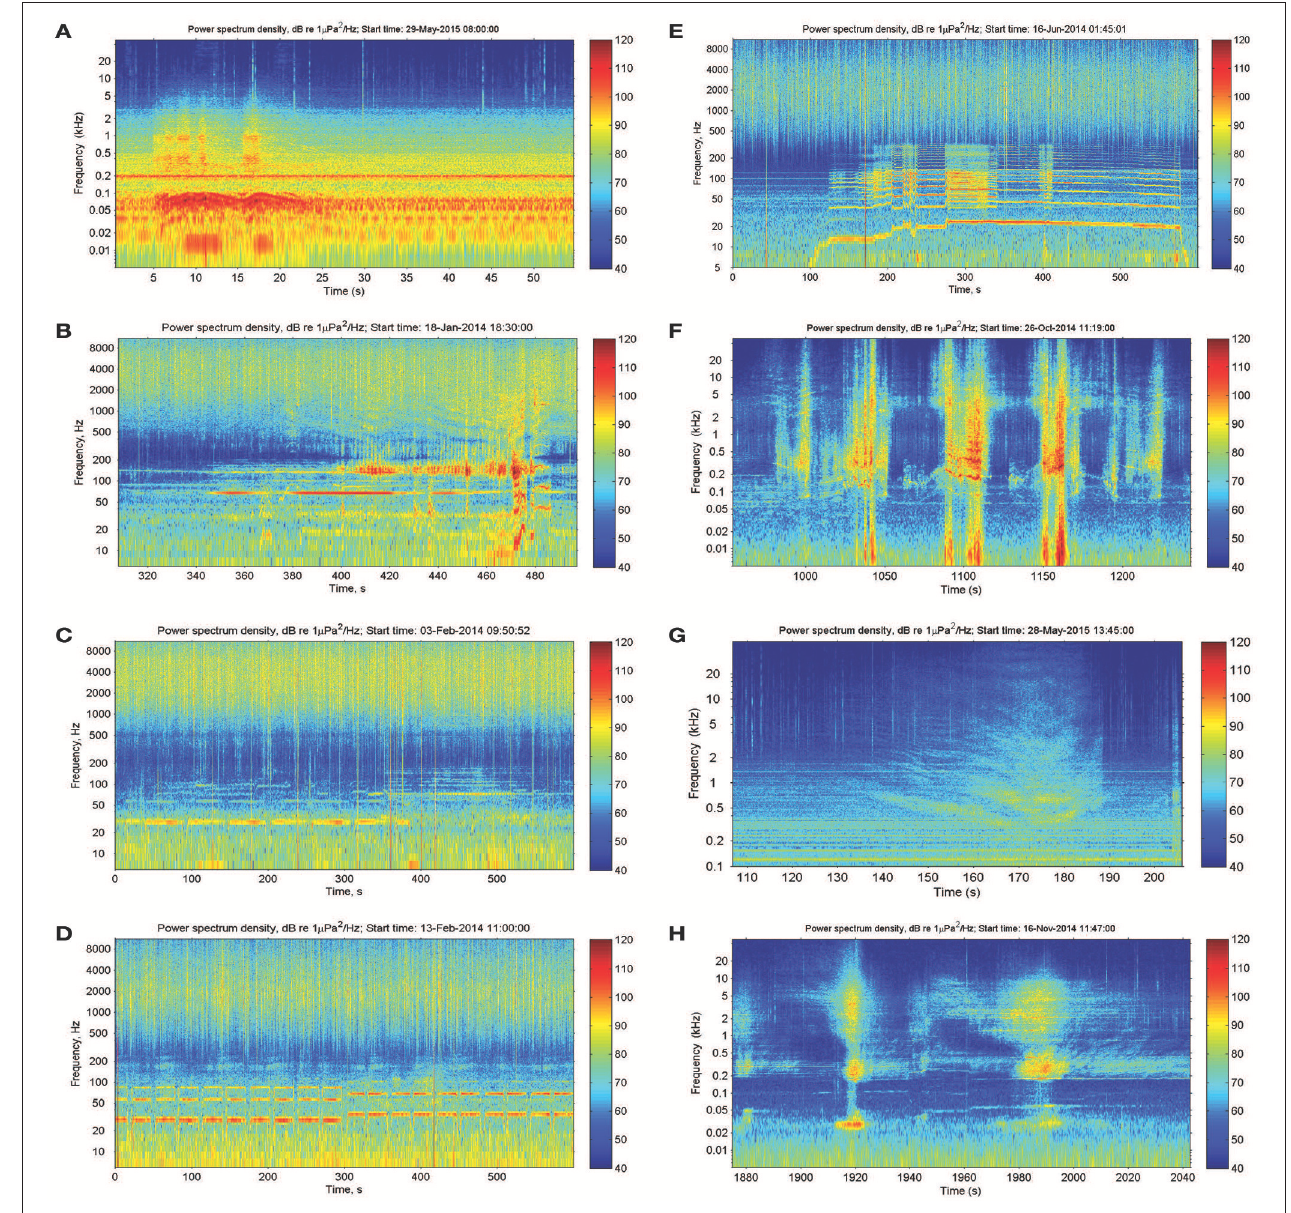
FIGURE 4 | A sample of the various types of sounds produced by vessel traffic in the Swan